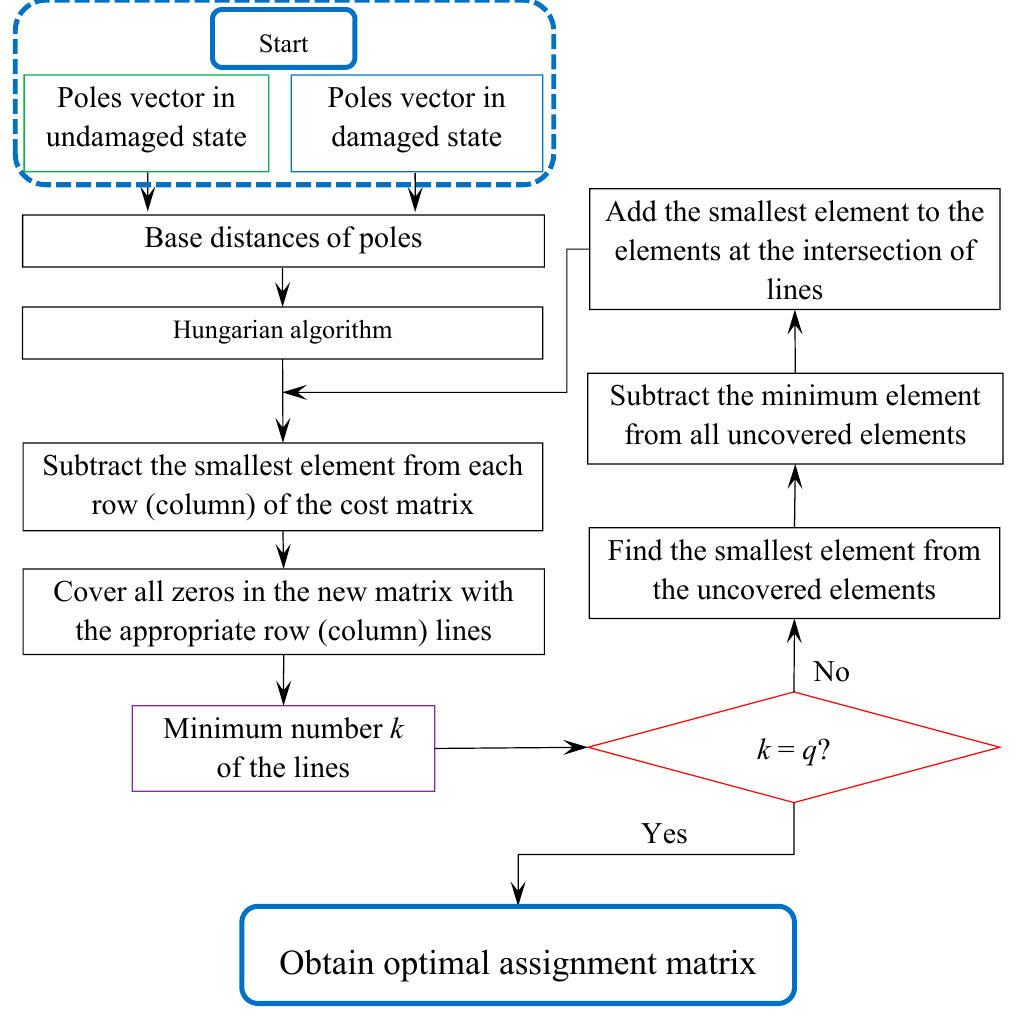
Figure 1. Flowchart of Hungarian algorithm for optimal assignment.